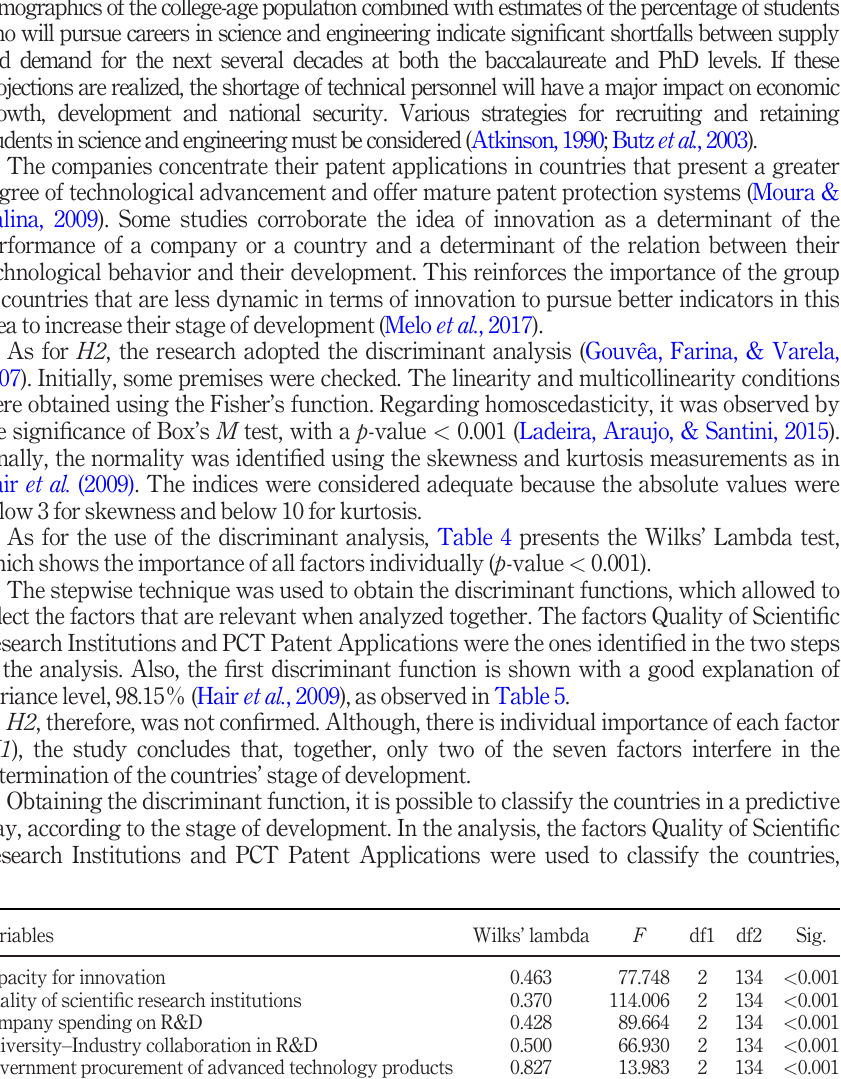
Table 4. Tests of equality